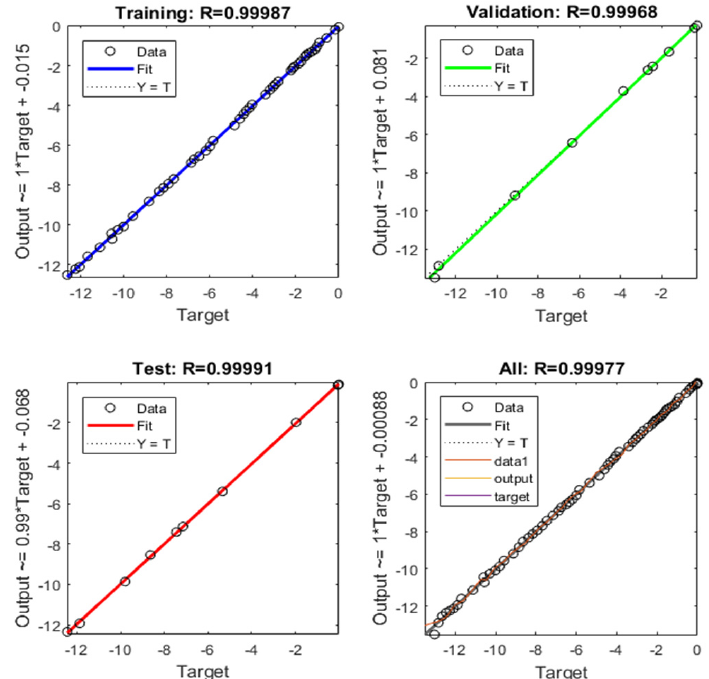
Figure 8. Prediction of the load vs. displacement relationship using ANN and using experimental observation for the training, validation, testing, and all datasets (BRC-1).